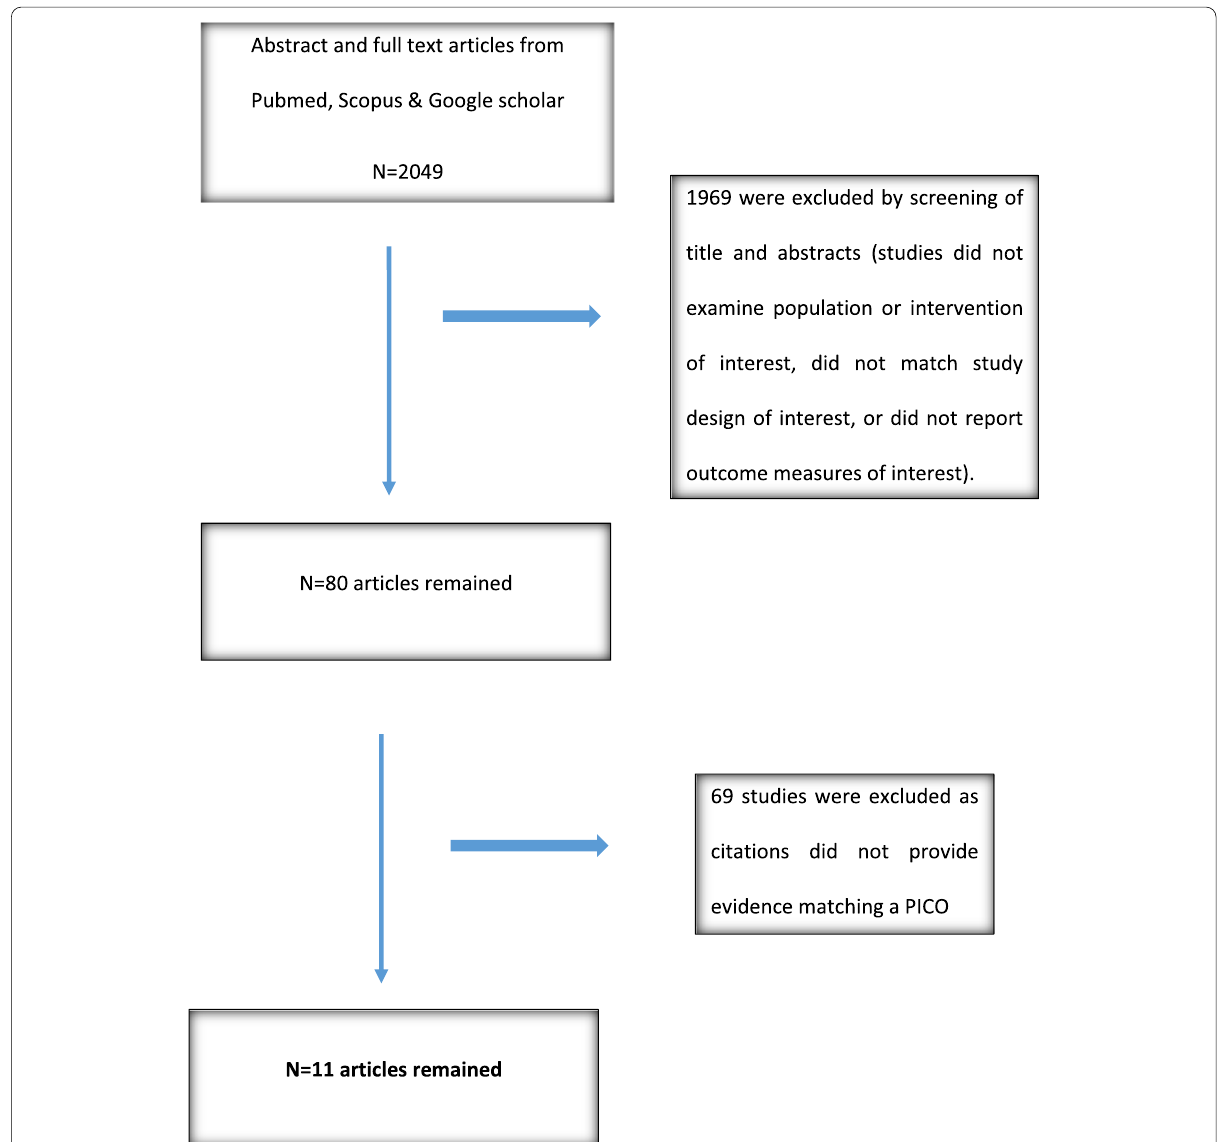
Fig. 1 Flow chart for the study selection process. PICO: Patient/ Population, Intervention, Comparison, and